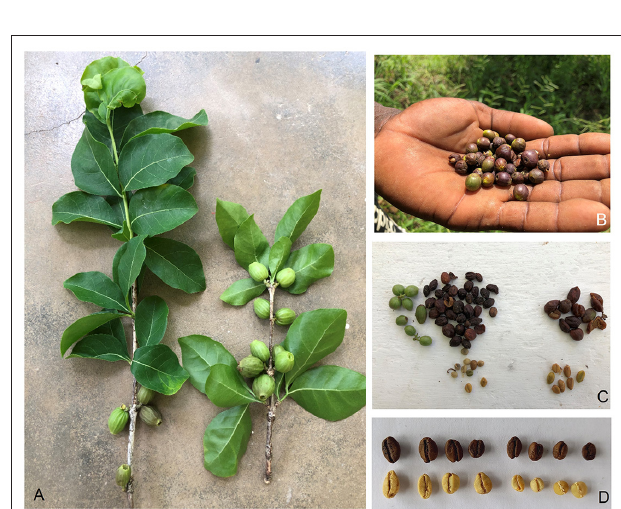
FIGURE 6 | Coffea zanguebariae. (A) Shoots of a cultivated plant, with immature fruits—left, showing upper (adaxial) surface of leaves; right, showing lower (abaxial) surface of leaves; (B) Ripening and almost ripe (mature) fruits, from farmed plants; (C) Fruits, and seeds enclosed in endocarp (parchment)—immediate left, immature fruits (green), uppermost, dried fruits (cherry) and lowermost, parchment coffee, indicating variation in parchment/seed size; (D) unroasted (above) and roasted (below) seeds of C. zanguebariae (four seeds to left), and compared to those of C. racemosa (right). Images (A–C) taken in north-eastern Mozambique, (A,C) on Ibo Island and (B) near Pemba, and (D) in the UK. Images: Aaron Davis.